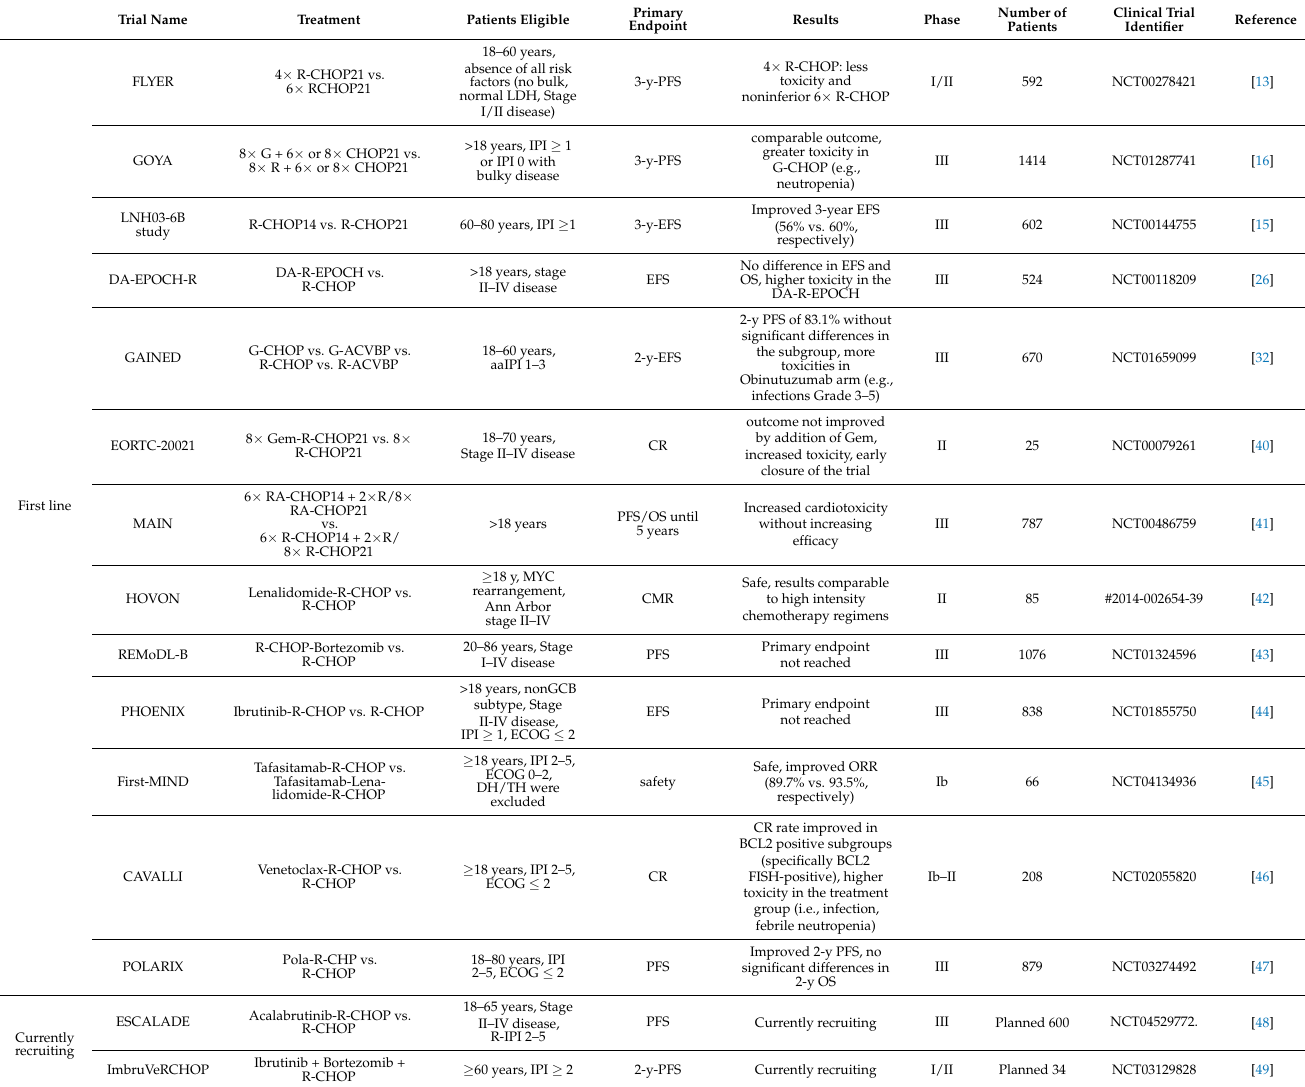
Table 1. Clinical trials in